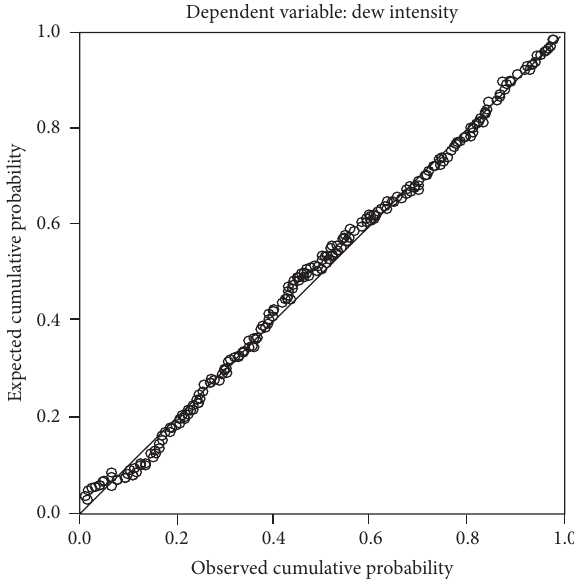
Figure 3: Normal P-P plots of regression standardized